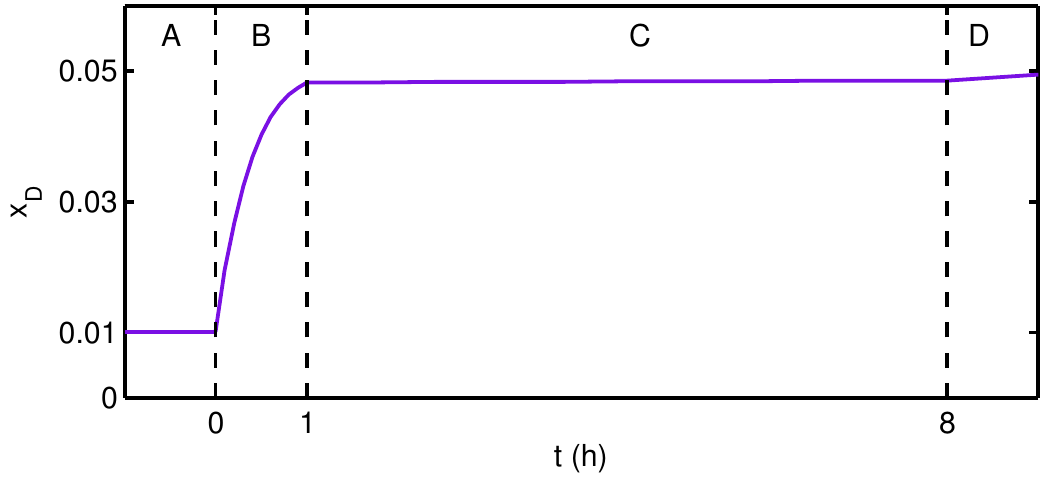
Figure 3. x during batch-wise downstream processing. ( A ) is the upstream processing and D protein A capture; ( B ) is the virus inactivation; ( C ) is the storage and pH adjustment and ( D ) is the CIEX